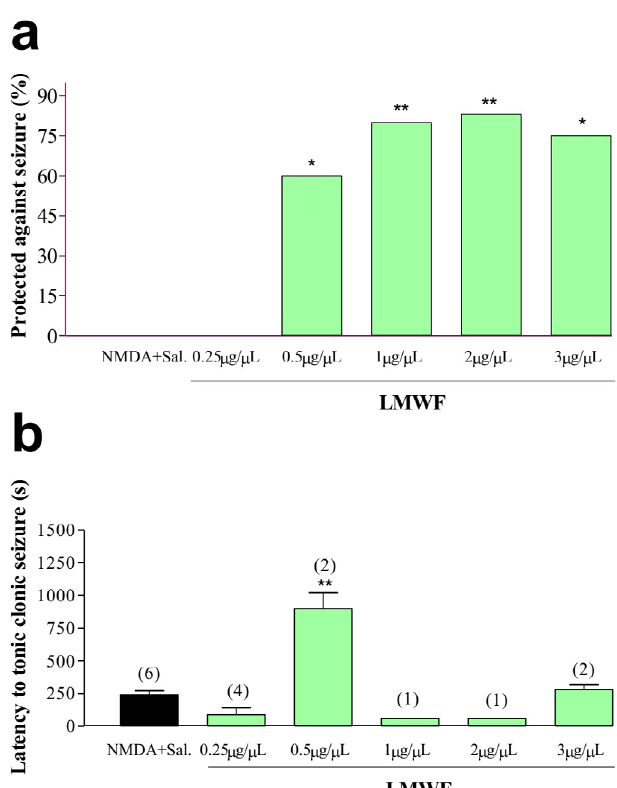
Figure 3. LMWF anticonvulsant activity in NMDA-induced seizure model. A: Mean percentages of animals protected against NMDA-induced seizures after injection of different concentrations of LMWF. Data analyzed using the chi-square test followed by Fischer’s test. * p <0.05 and ** p <0.01 compared to the control. B: Mean ± SEM of the latencies for triggering seizures in animals not protected against NMDA-induced seizures after injection of different concentrations of LMWF. Data were analyzed using ANOVA test followed by Tukey post-test. * p <0.05 and ** p <0.01. The numbers in parentheses above the columns represent the number of animals used.